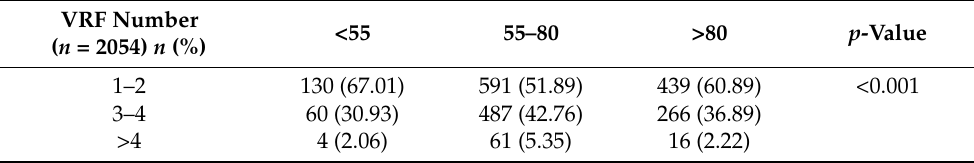
Table 3. Relationship between the number of vascular risk factors and age